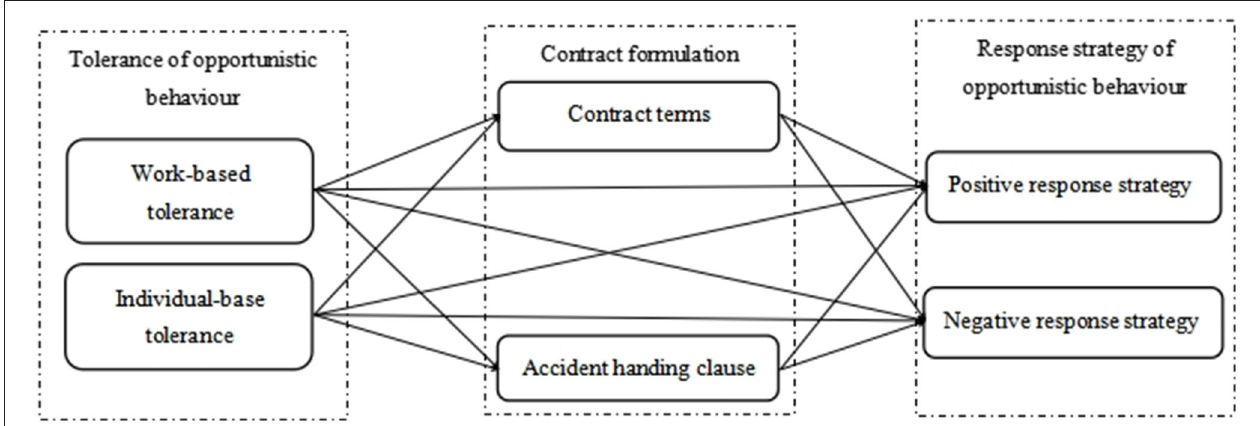
FIGURE 1 | The relationship model between tolerance of opportunistic behavior, contract formulation, and response strategy of opportunistic behavior.